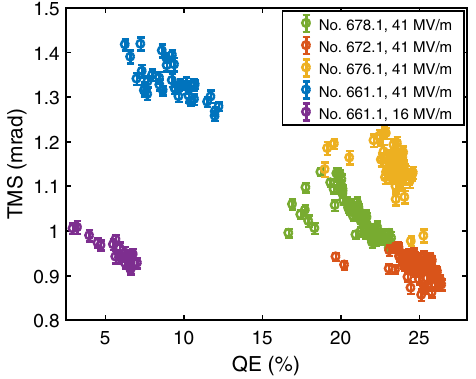
FIG. 5. The schematic of the Schottky barrier model in the junction between Cs 2 Te and Mo